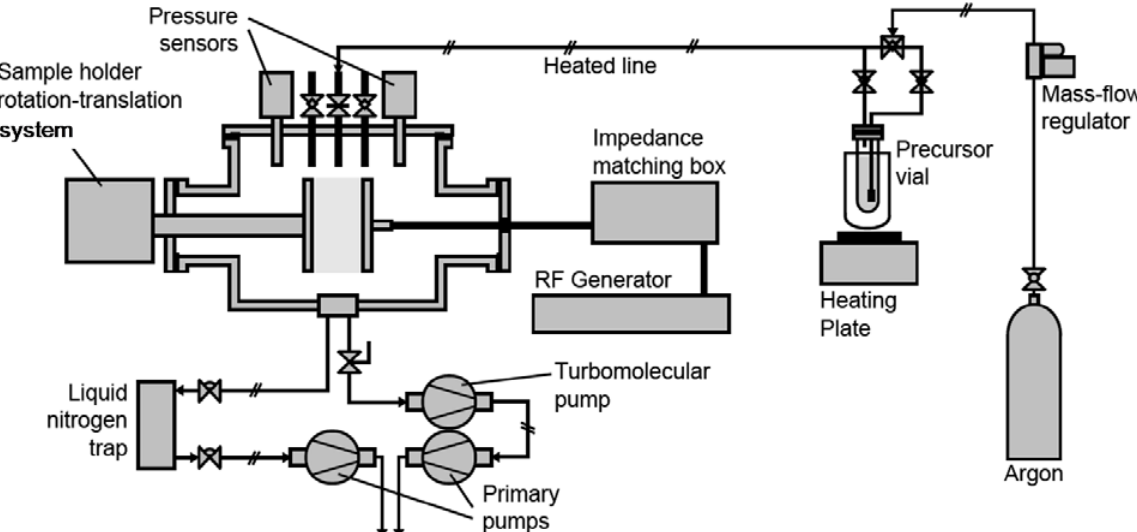
Figure 13. Plasma process